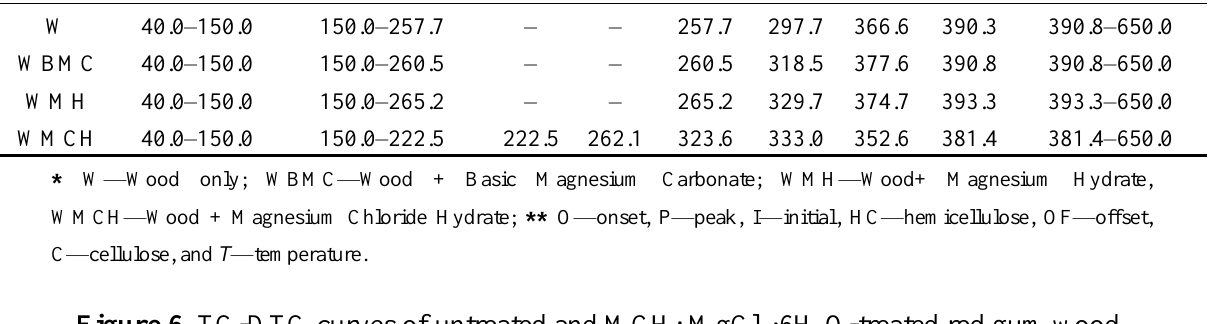
Figure 6. TG-DTG curves of untreated and MCH: MgCl